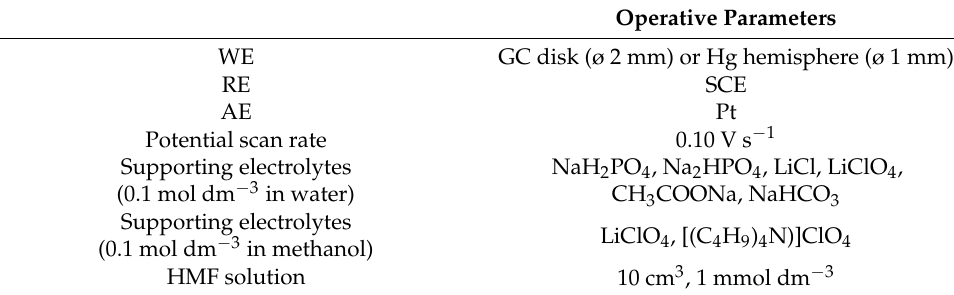
Table 1. CV operative conditions.